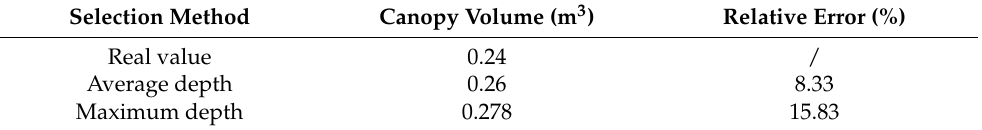
Table 3. Effect of the mesh canopy thickness setting method on the volume